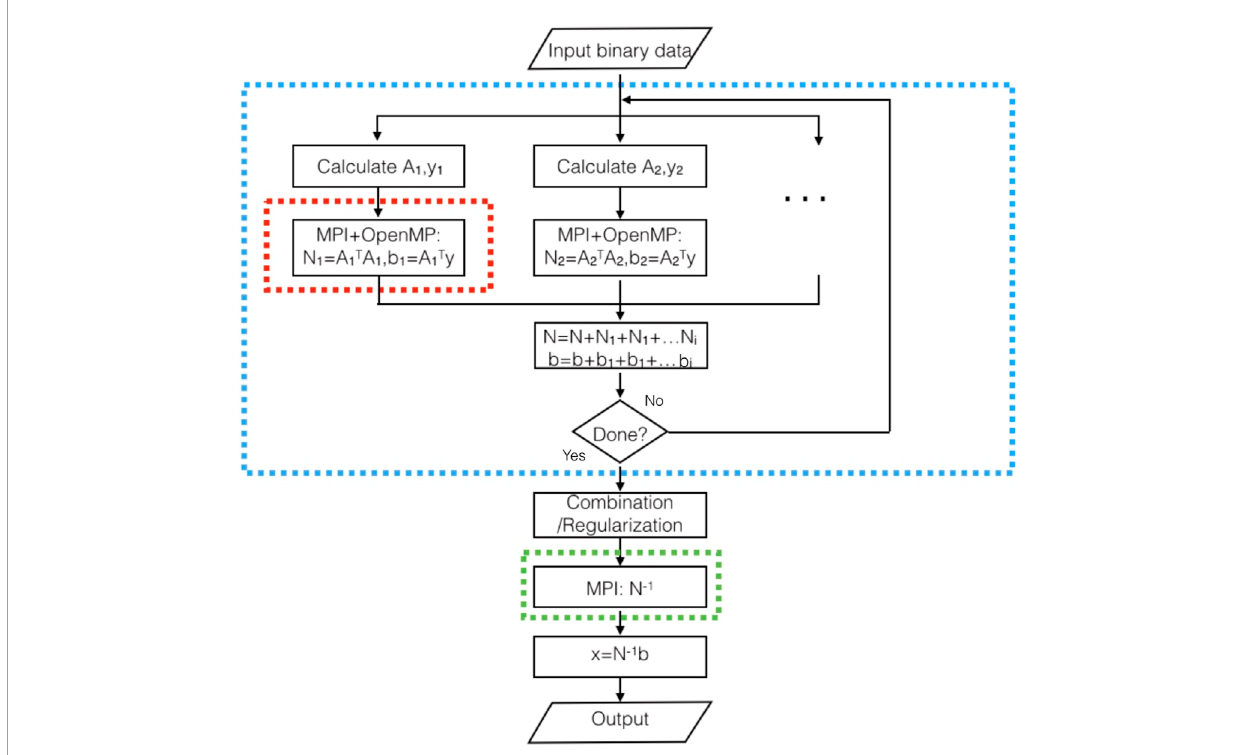
FIGURE 1 The parallel numerical calculation process by combining MPI and OpenMP in gravity field recovery.